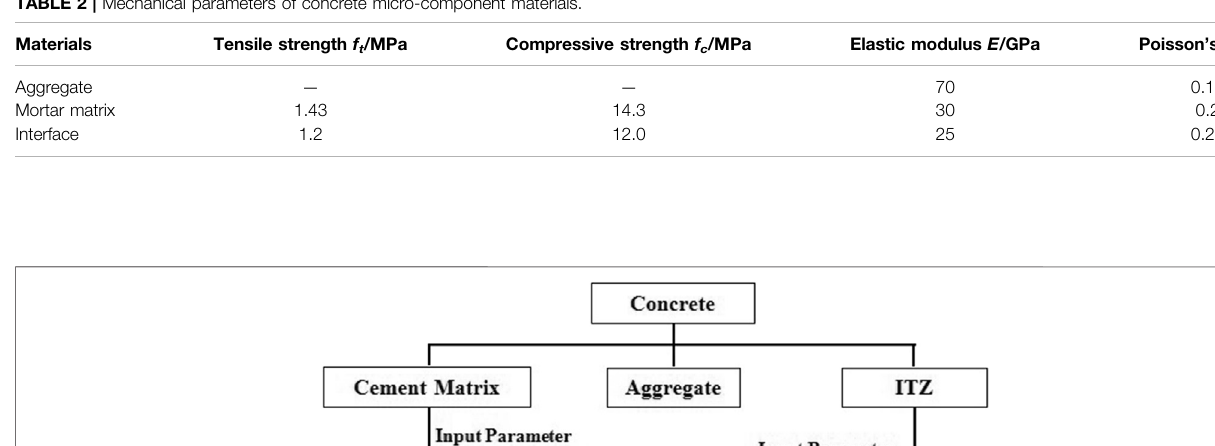
Frontiers in Physics |